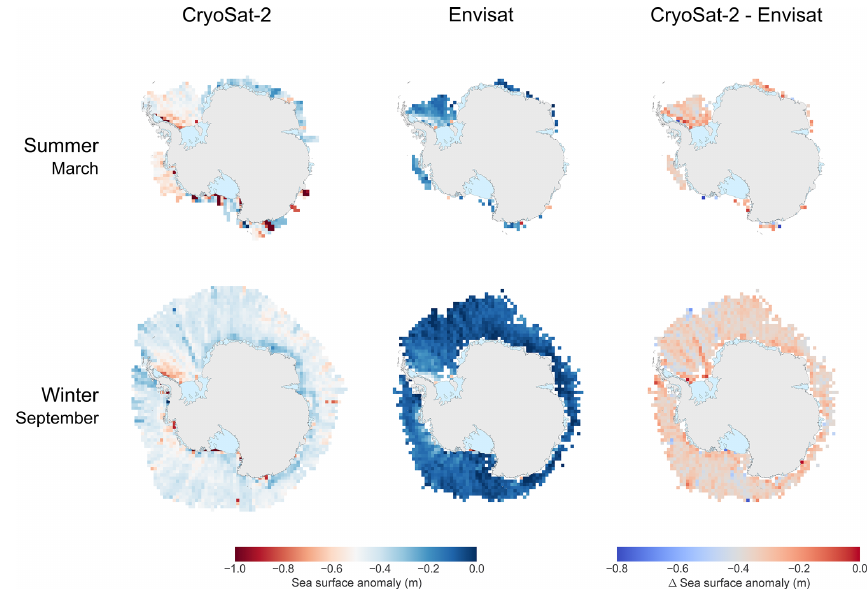
Figure 5. Sea-surface anomaly for summer (top panels) and winter (bottom panels), derived from CryoSat-2 (left panels) and Envisat (center panels), and the difference between both products. The difference plot indicates a bias between the CryoSat-2 and the Envisat sea-surface